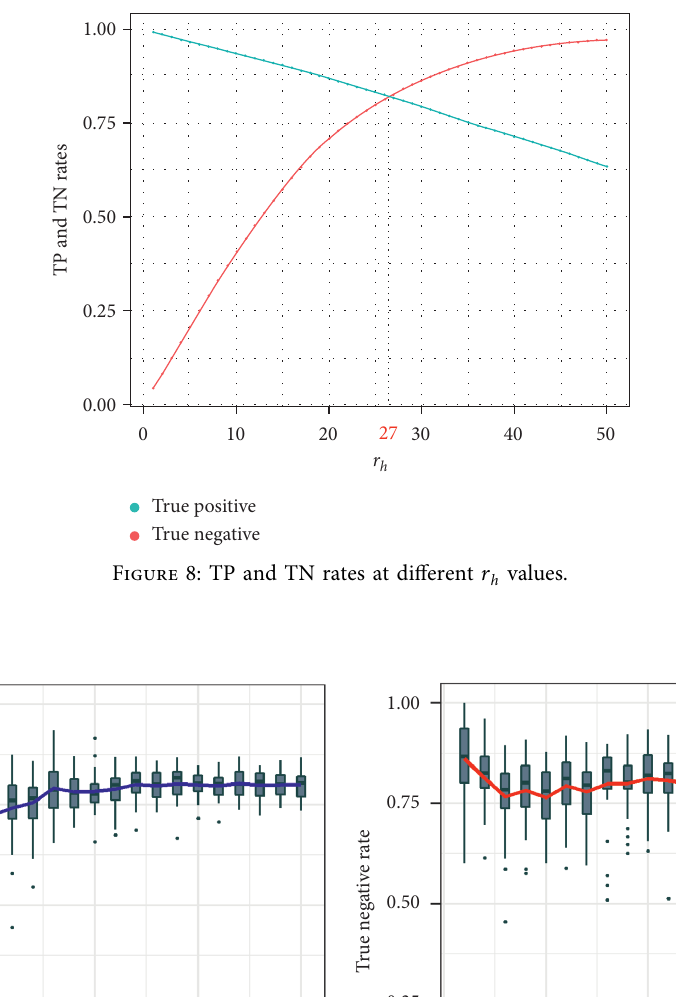
� 27. (b) TN rates at different MPRs when r h